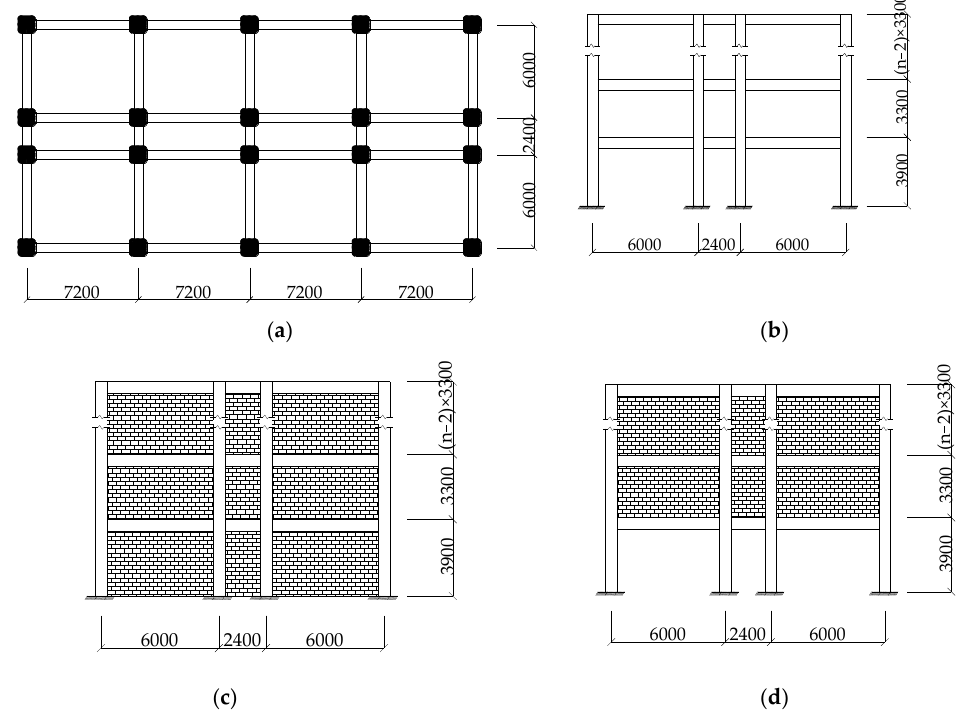
Figure 1. Plan and elevation views of RC frame structures with/without infill walls: ( a ) plan; ( b ) elevation of bare frame; ( c ) elevation of fully infilled frame; ( d ) elevation of the bottom soft-story infilled frame.